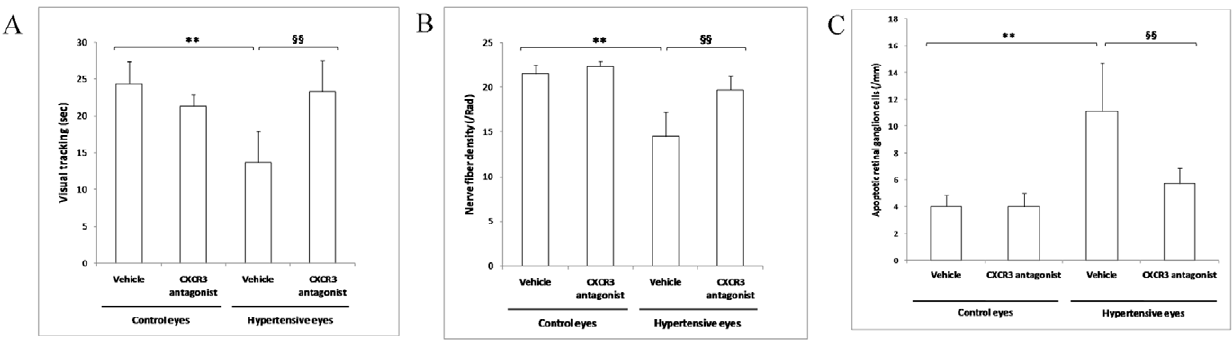
Figure 6. CXCR3 antagonism-induced lowering of intraocular pressure prevents retinal neurodegeneration and protects visual function in a rat model of ocular hypertension. (A,B) Ocular hypertension during 3 months is associated with a degradation in the visual function (A) as assessed by the duration of visual tracking during a 1-min optokinetic testing (spatial frequency, 0.5 cycle/degree), and with a decrease in retinal nerve fiber density (B) as measured in vivo by scanning light ophthalmoscopy. Ophthalmic treatment with CXCR3 antagonist significantly protects the visual function and prevents retinal nerve fiber loss (n=10 each). (C) Ocular hypertension during one month is associated with an increase in retinal ganglion cell apoptosis (reported as the number of TUNEL-labeled cells normalized to the observed retinal layer length), which is reversed 15 days after the treatment with CXCR3 antagonist (n=10 each). ** P , 0.01 vs. normotensive eyes, 11 P , 0.01 vs. untreated hypertensive eyes. Data in graphs are presented as means 6 SEM.